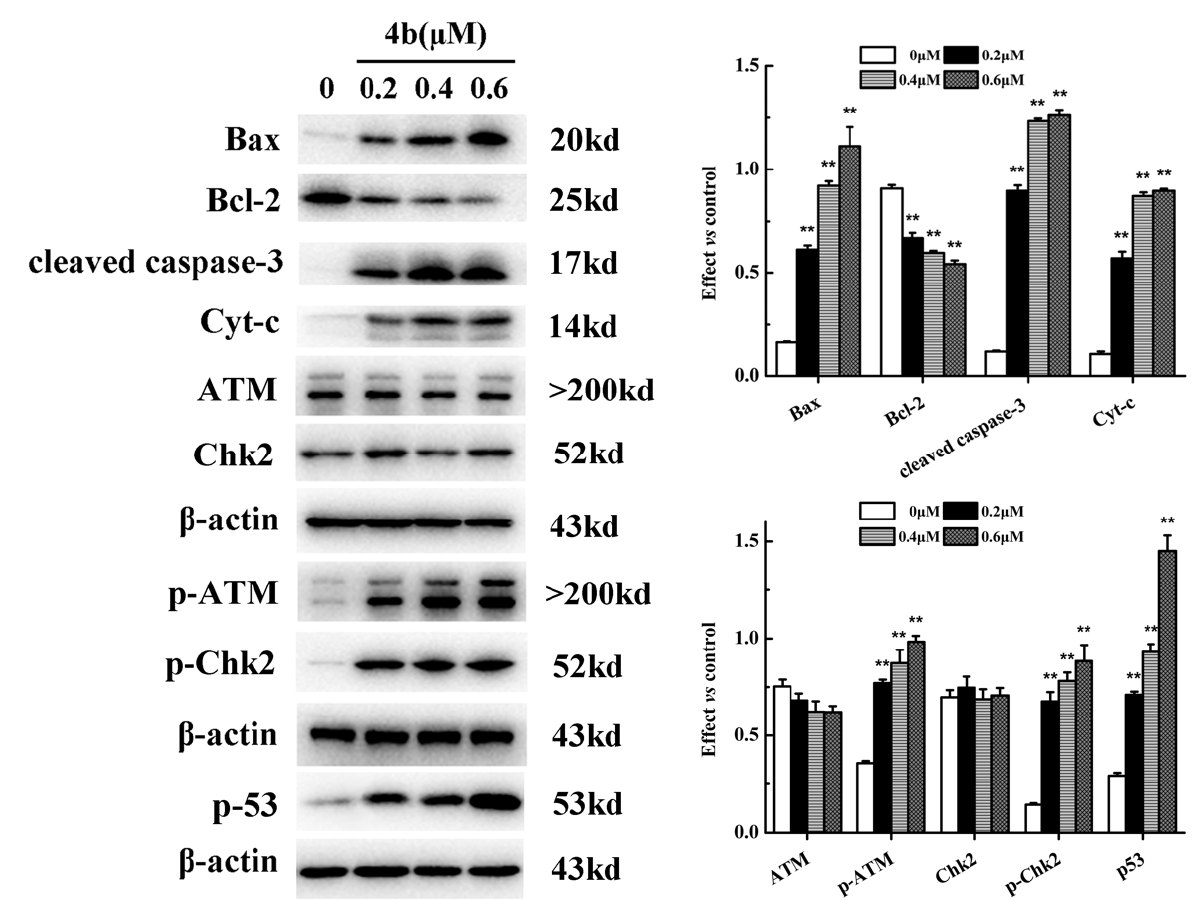
Figure 5. Western blot analysis of complex 4b in MCF-7 cells. Cells were cultured in the presence of different concentrations of 4b for 24 h. Whole-cell lysate was analyzed for Bcl-2, Bax, cleaved caspase-3, Cytochrome c, ATM, p-ATM, Chk2, p-Chk2, and p53 by immunoblotting. A representative anti- β -actin immune blot was shown as the loading control. Error bars show the SD, “**” p < 0.01, compared with the control.